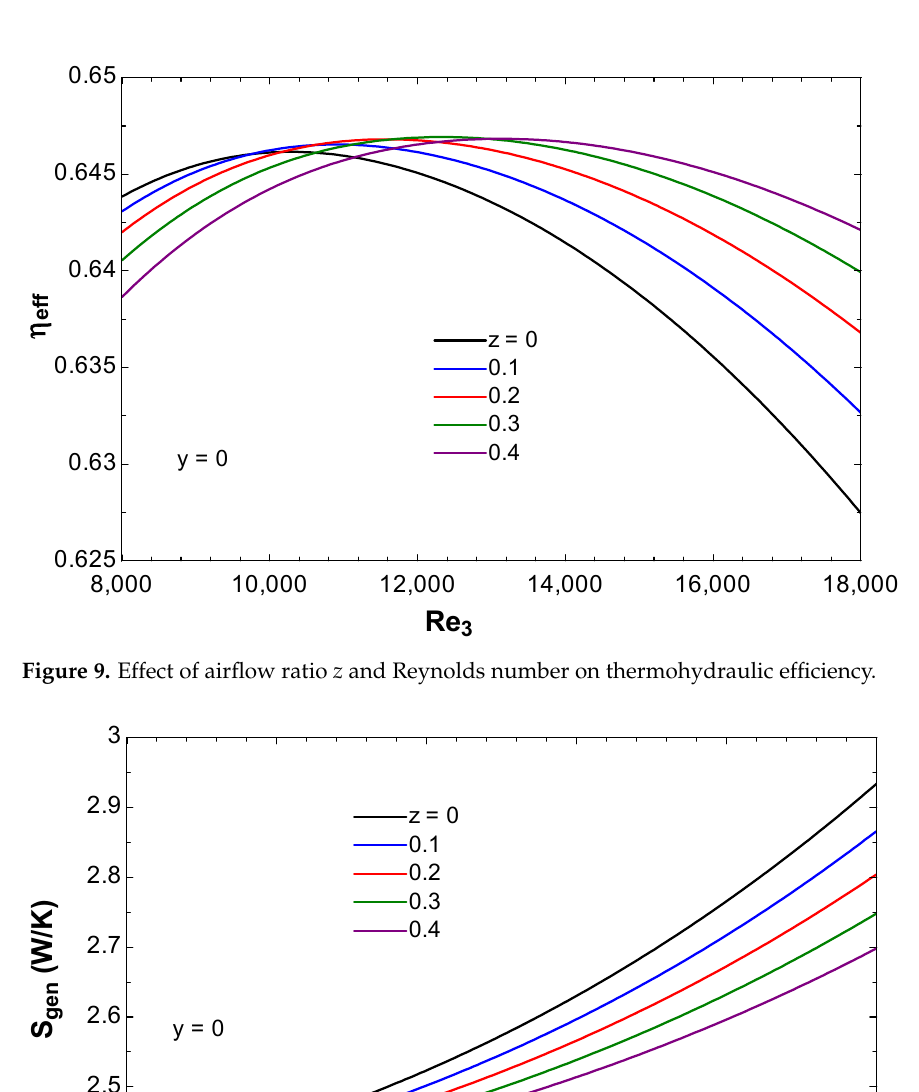
Figure 11. Effect of airflow ratio y and Reynolds number on thermohydraulic efficiency.